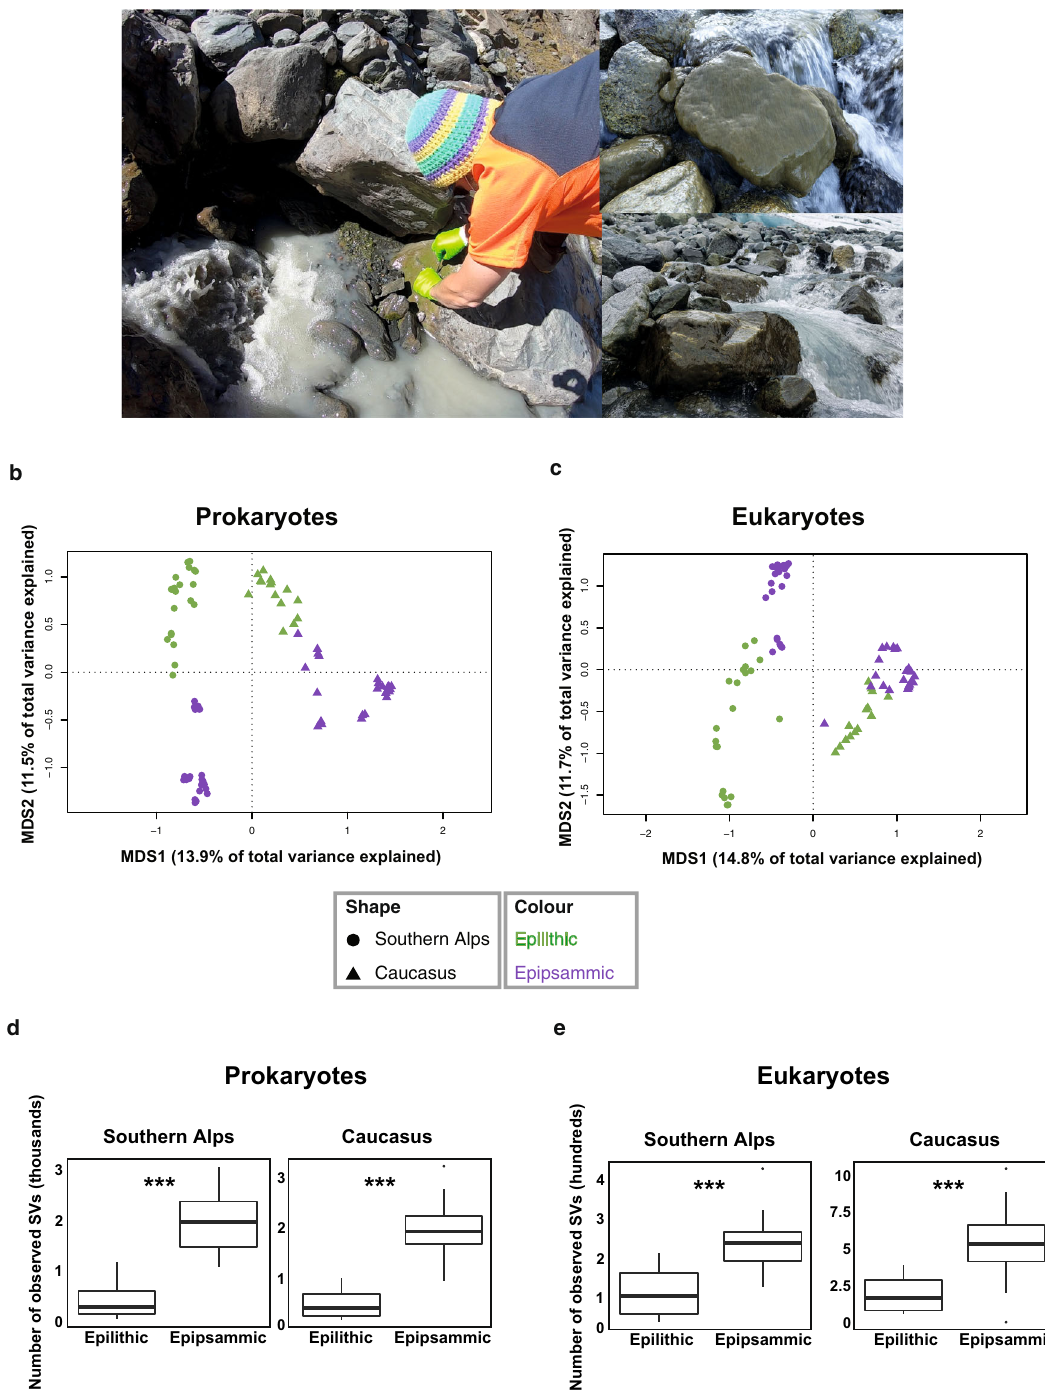
Fig. 1 Sedimentary habitats affect microbiome structure and assembly. a Representative images of sample collection indicating GFS and adjacent epilithic bio fi lm (left) with images of epilithic bio fi lms (right). Photo credits: Martina Schön and Matteo Tolosano. Ordination analyses of the epipsammic ( n = 27 biologically independent samples) and epilithic ( n = 21 biologically independent samples) bio fi lm based on prokaryote ( b ) and eukaryote ( c ) metabarcoding pro fi les from Southern Alps and Caucasus. Microbial richness across geographic locations and sample types in ( d ) prokaryotes and ( e ) eukaryotes. The statistical analyses was performed on 27 epipsammic and 21 epilithic samples using a two-sided non-parametric t test. Bonferroni- corrected p values are indicated by *, i.e., *** represents p < 0.001. Boxplots represent the median richness with the 25th and 75th quartiles observed within the